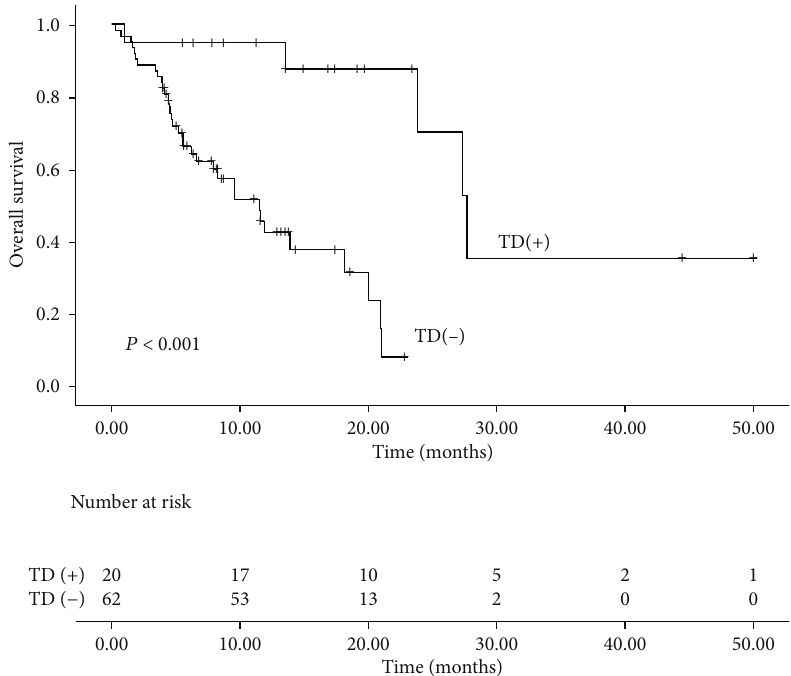
Figure 2: Overall survival in ESCC patients with and without